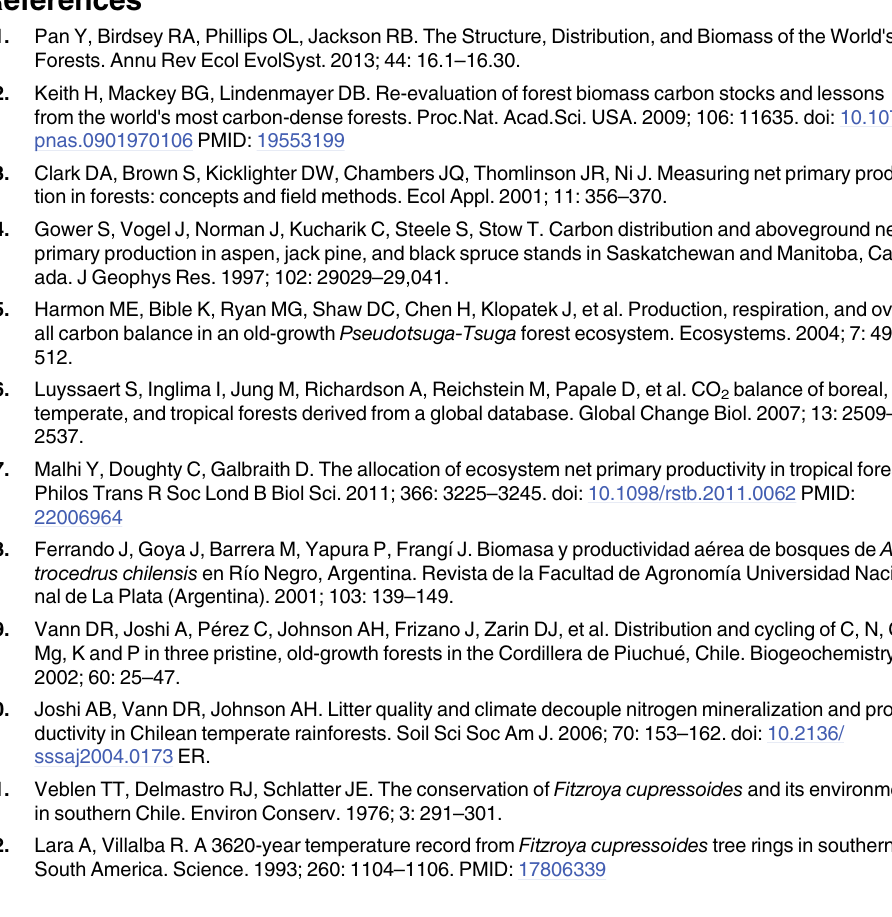
(Figure H). Litterfall per component per plot (Figure